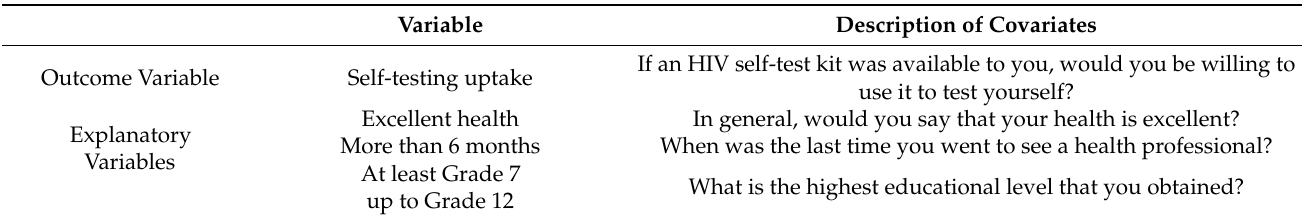
Table 1. Outcome and explanatory variables used in the